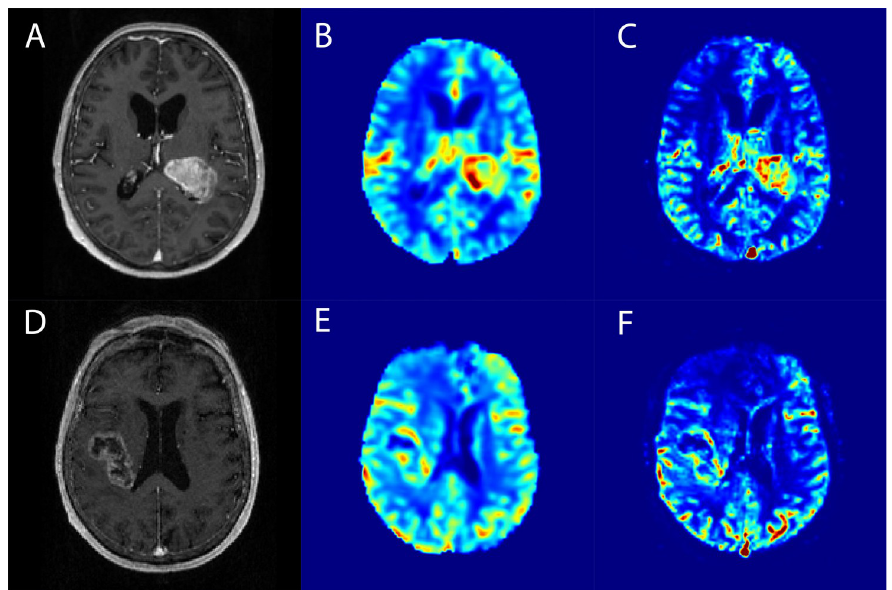
Fig 1. Example images of on spatially corresponding axial processed MR data: contrast-enhanced T1w anatomical images (A, D), relative CBV (B, E), and wavelet-MRP (C, F).